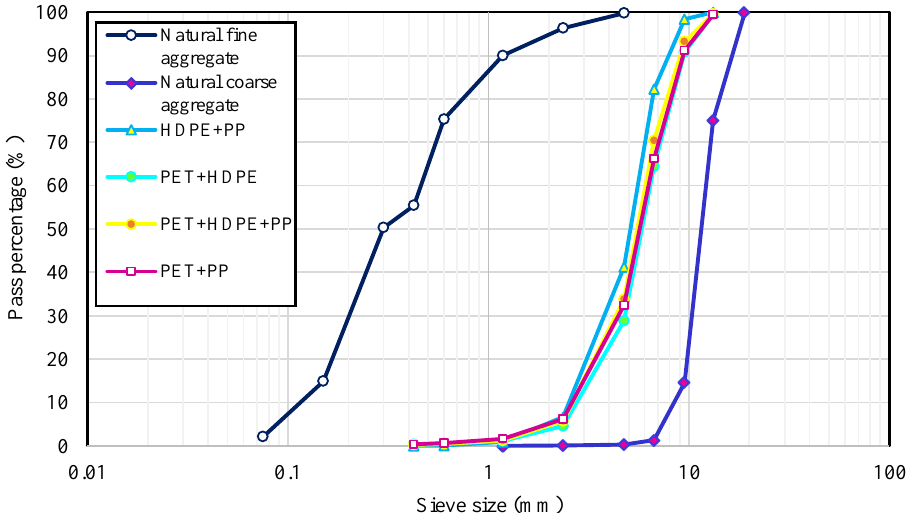
Figure 2. Particle size distribution of natural and plastic aggregates.